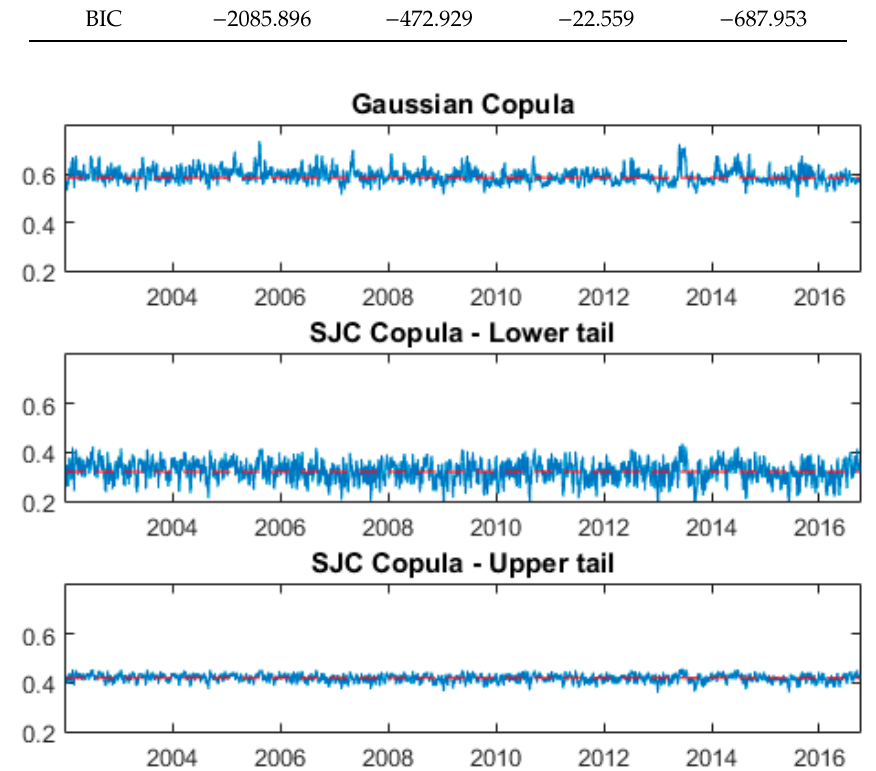
Figure 5. Dependence path of the time-varying copula for PM 10 —CO.